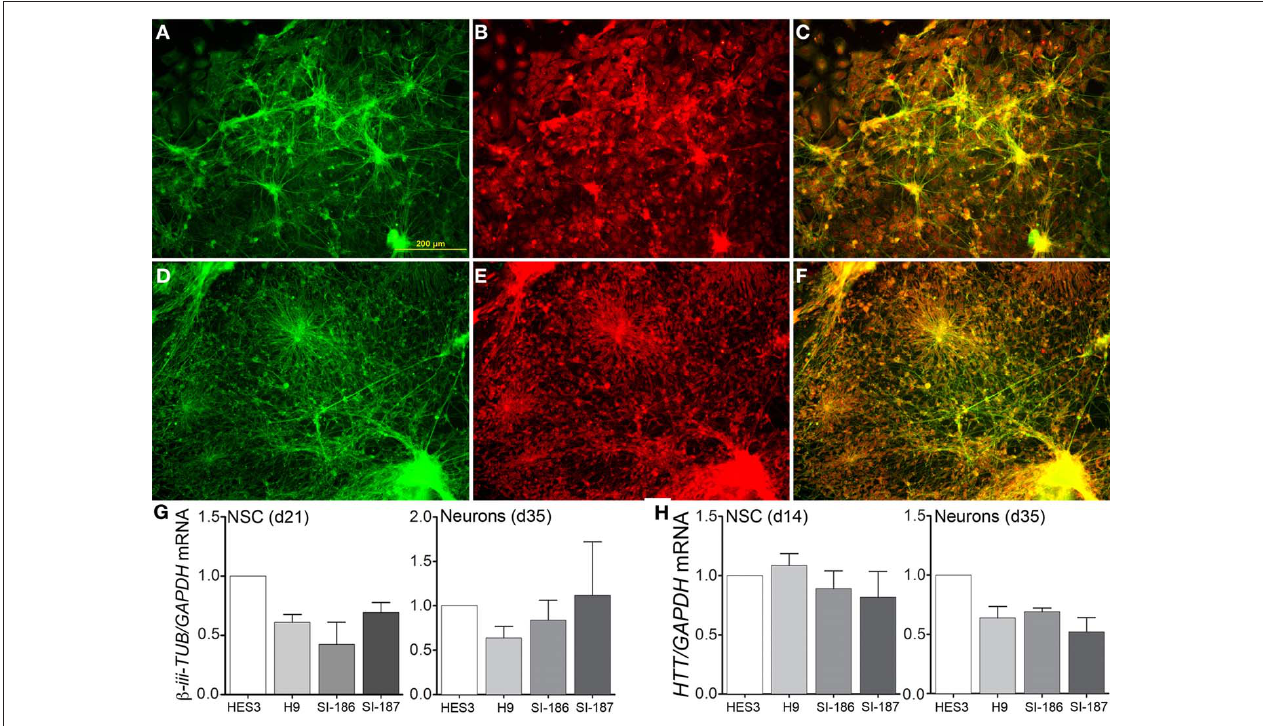
localization within neuronal cells. (G) Neuronal differentiation qRT-PCR comparisons of β -iii-TUBULIN expression during late neurosphere (d21) and neuronal (d35) stages. (H) HTT transcript expression across HD and control lines during mid-neurosphere (d14) and neuronal (d35)